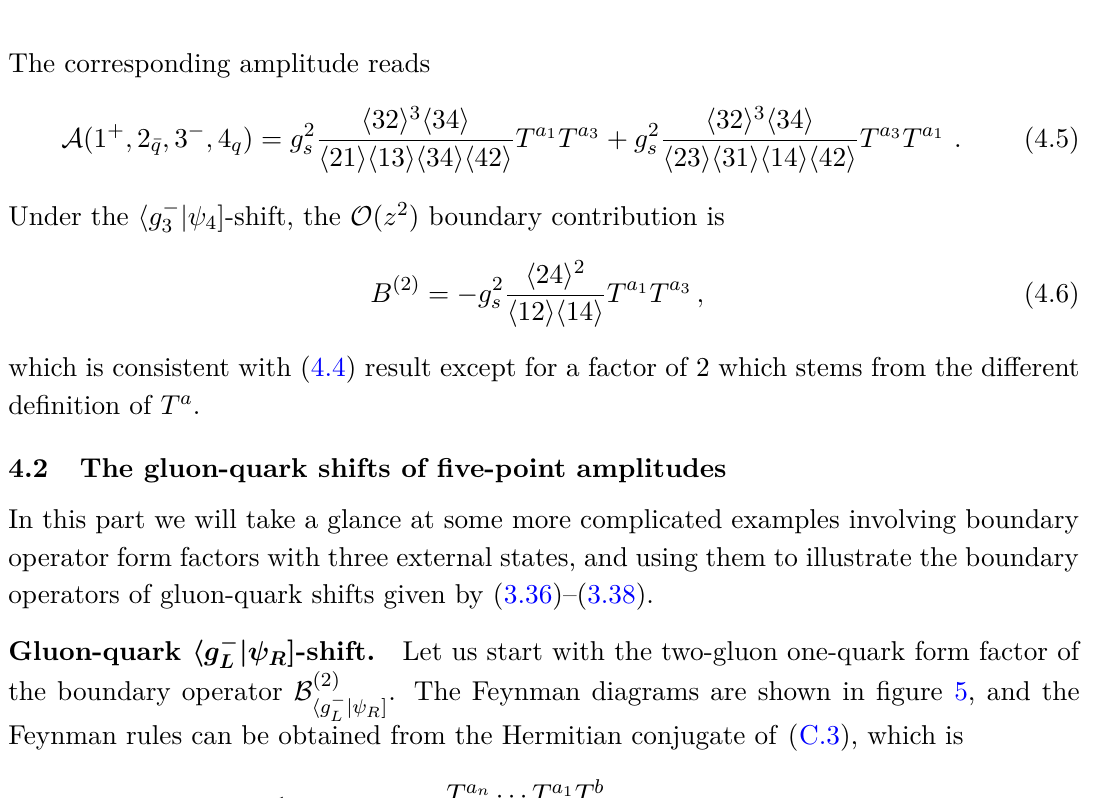
Figure 4 . Two contributing Feynman diagrams for computing boundary contribution of four-point QCD amplitude under h g − | ψ R ] L